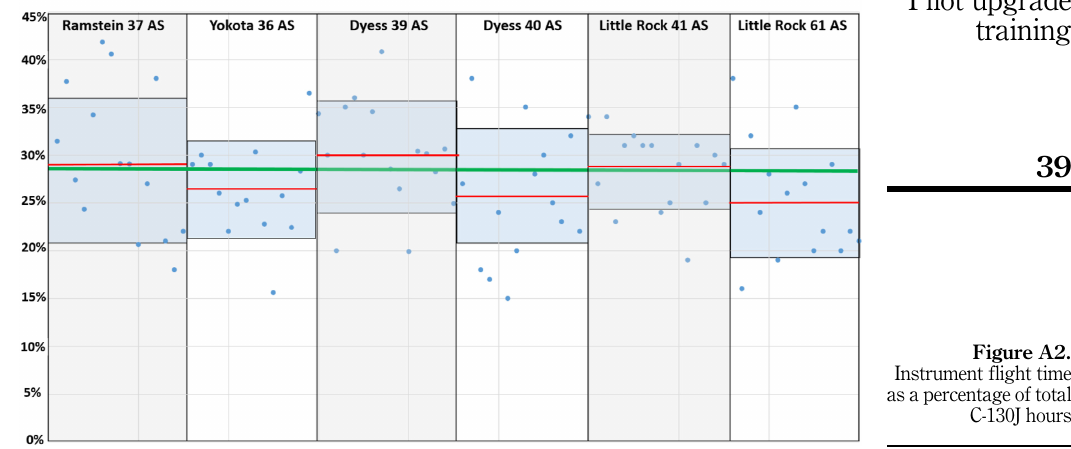
Figure A2. Instrument flight